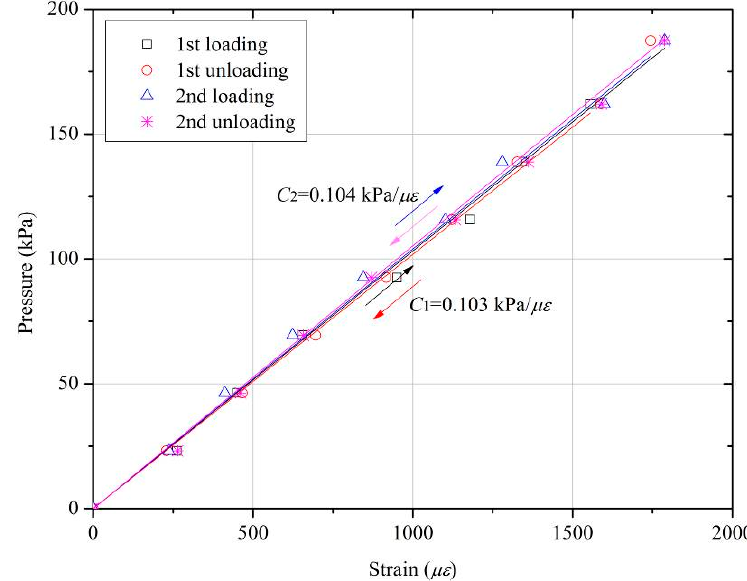
Figure 9. The calibration results of pressure-strain relationship between applied pressures and measured strains from FBG sensors.